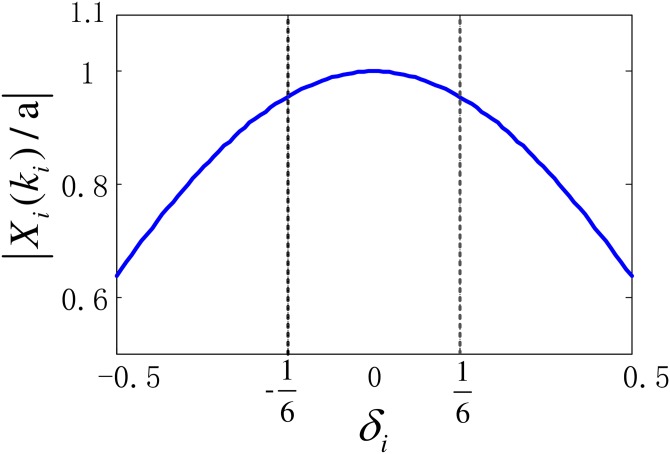
Normalized magnitude of peak bin versus δi.